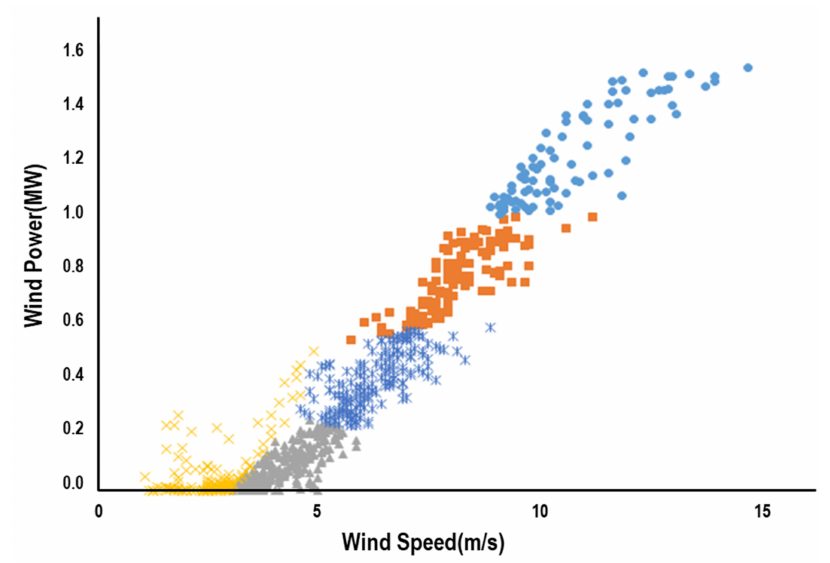
Figure 6. Refined Data for Power Curve Modeling of 1.5 MW